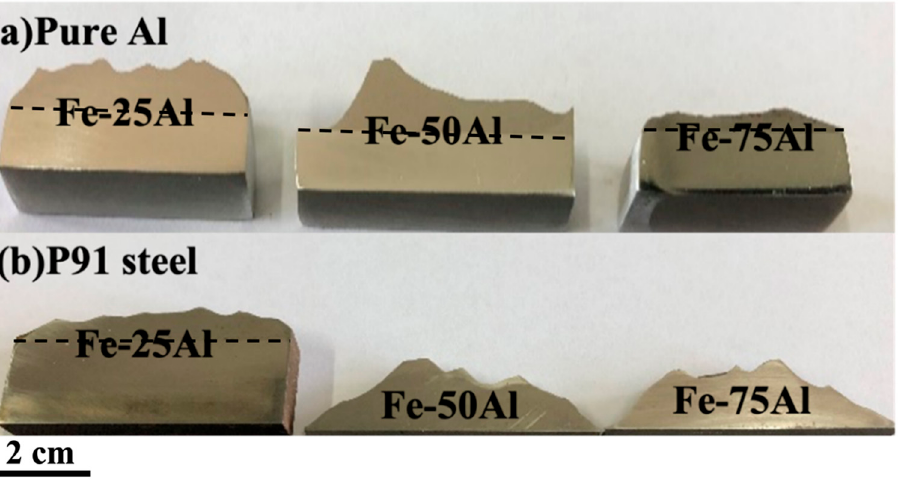
Figure 6. Images of as-sprayed samples after wire cutting and polishing: ( a ) samples with pure Al substrate; ( b ) samples with P91 steel substrate.